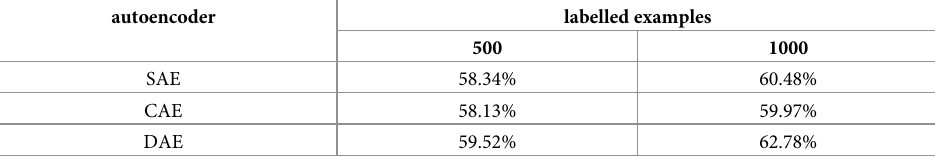
Table 5. On the CSC test set, results of the variant of autoencoders on our model.